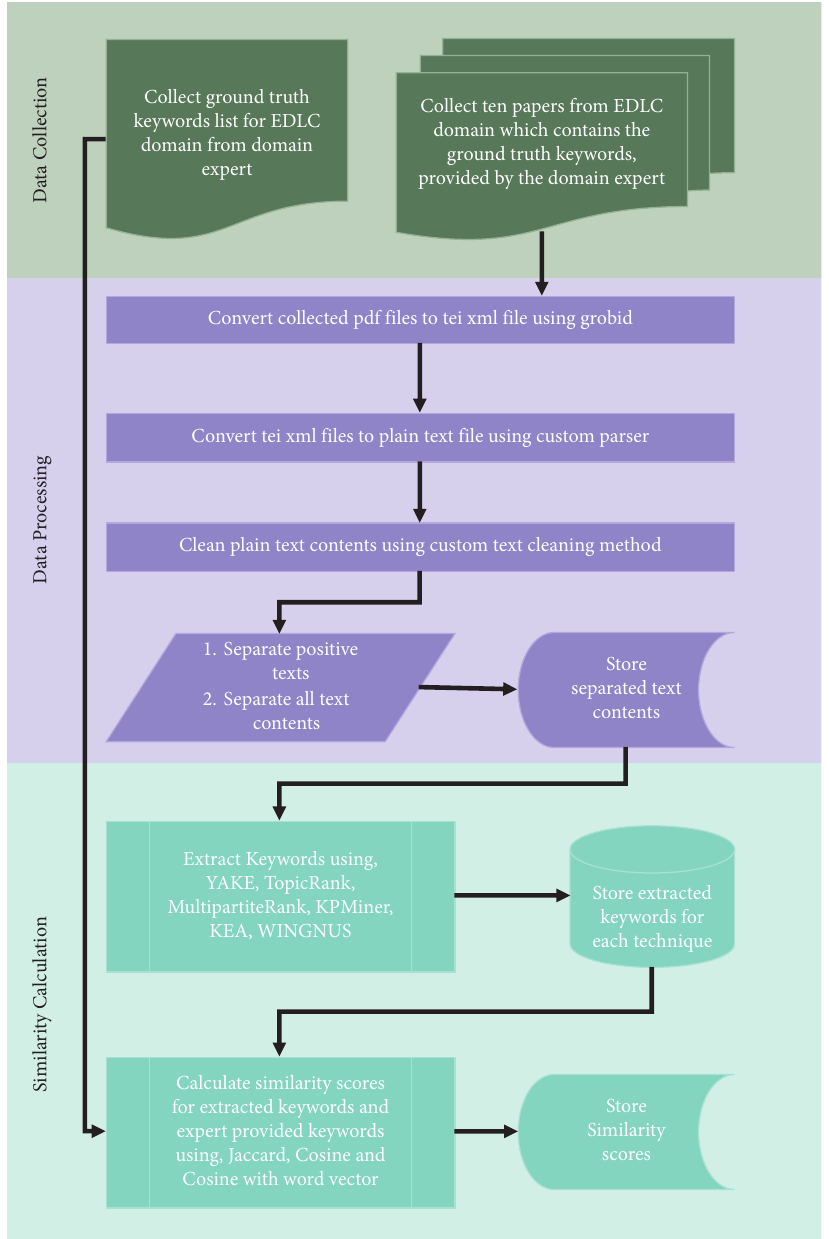
Figure 1: Overview of the employed